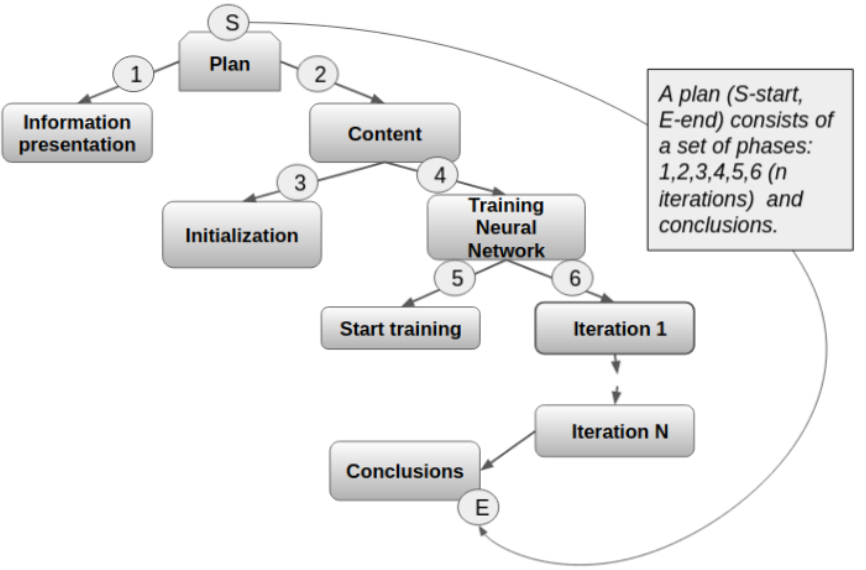
Figure 7. Planning for the video presentation of HNNs execution